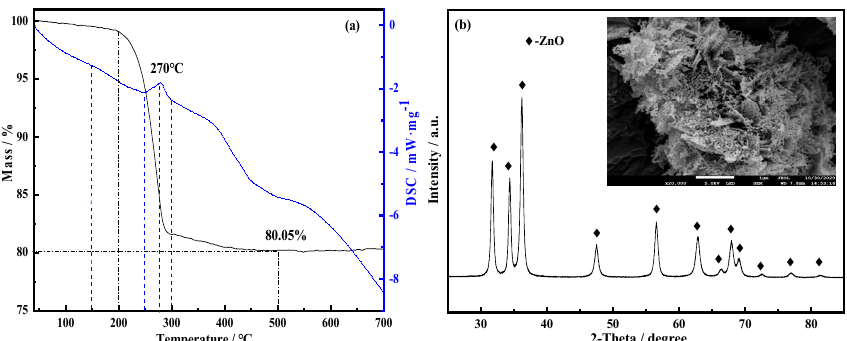
Figure 9. ( a ) Thermogravimetric-differential thermal curve of basic zinc carbonate ( b ) XRD and SEM of the product calcined at 500 °C for 60 min.